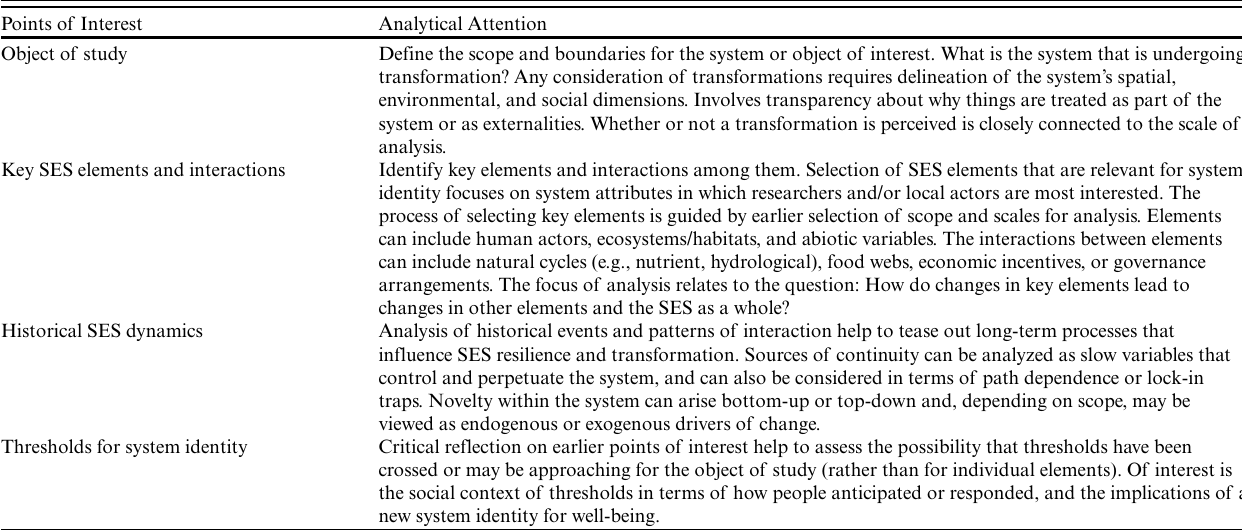
Table 1 . Analytical points of interest for conceptualizing and perceiving social-ecological